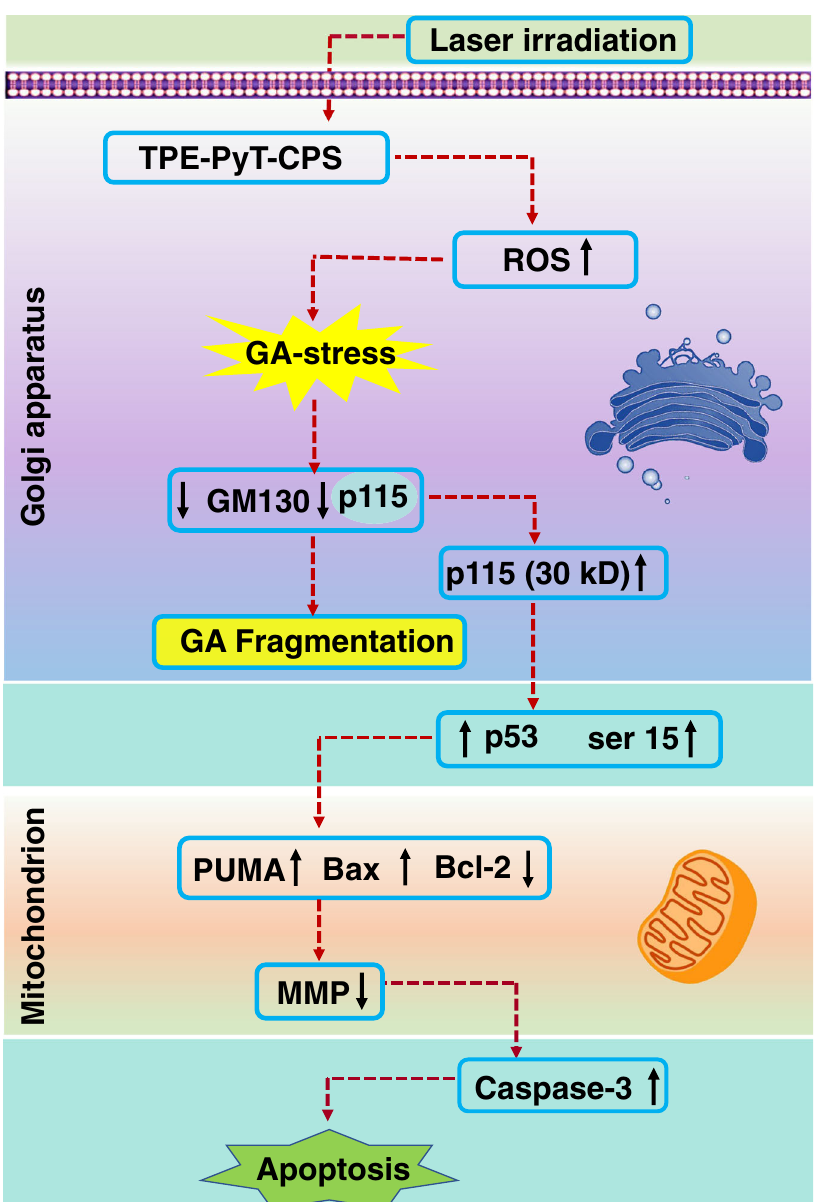
Fig. 9 Golgi oxidative stress leads to the decrease of mitochondrial membrane potential, which leads to apoptosis. Proposed mechanism for the cell apoptosis through the crosstalk between Golgi apparatus and mitochondria in GA-targeted photodynamic therapy. ↑ : represents the increased concentration or up-regulated expression. ↓ : represents the decreased value or down-regulated